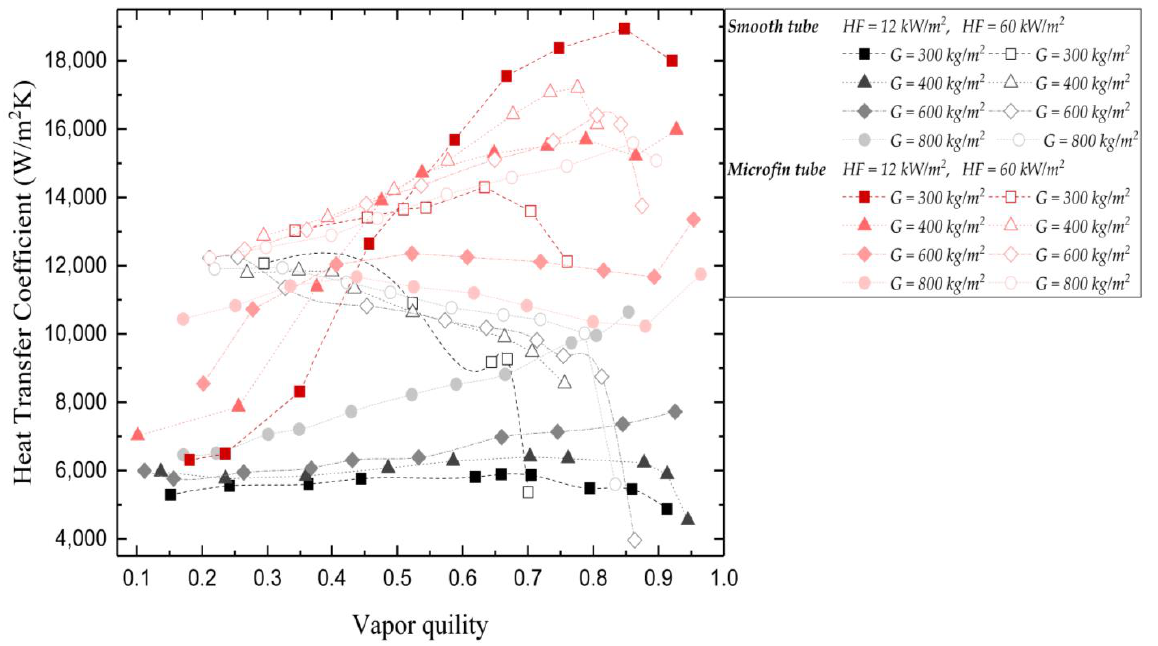
Figure 13. Mass velocity influence on two-phase frictional pressure drop at a T sat = 20 °C and HF = 30 kW/m 2 [73].